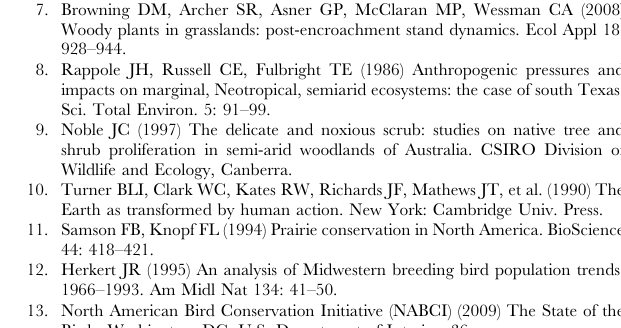
Figure S1 Schematic maps of sampling design applied at each control site. Each site is shown with sampling areas outlined (left) and delineations for analysis of grassland/tree row edge versus grassland interior areas (right). Figure S2 Schematic maps of sampling design and tree row removal at each treatment site. Each site is shown with sampling areas outlined (left) and delineations for analysis of grassland/tree row edge versus grassland interior areas (right). Areas of woody vegetation removal beyond focal tree rows are outlined in green